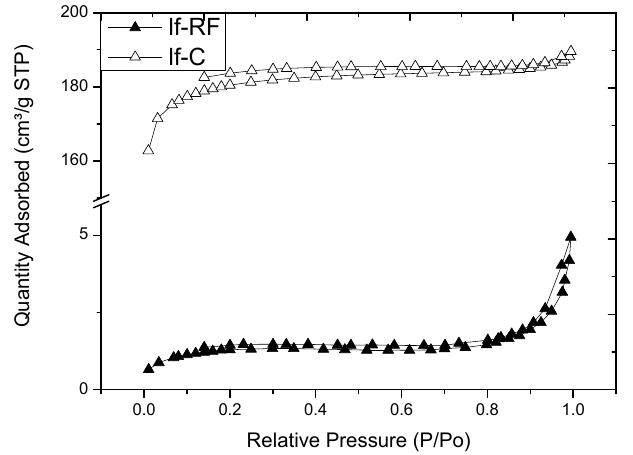
Figure 7. Adsorption and desorption isotherms of lf-RF and lf-C aerogels.